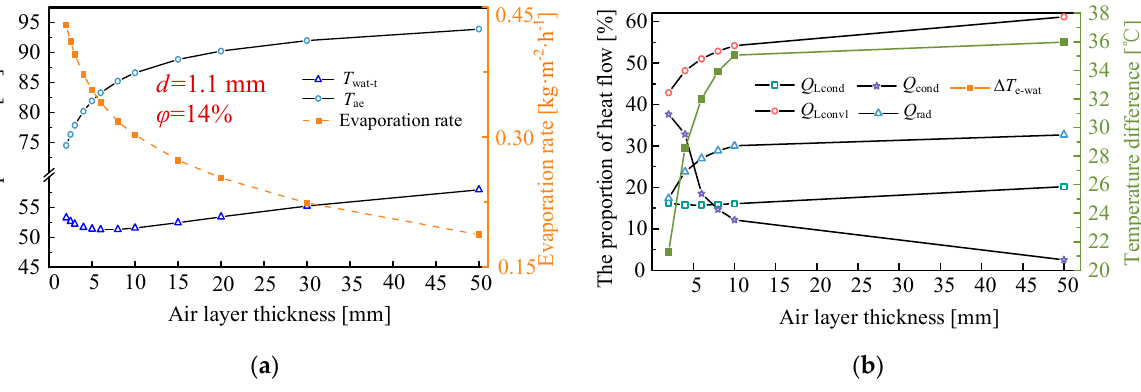
Figure 10. ( a ) T ae , T wat-t and evaporation rate under different air layer thickness, with the same hole diameter ( d = 1.1 mm) and hole area ratio ( φ = 14%). ( b ) The temperature difference between the water surface and infrared emitter surface and the proportion of heat flow under different air layer thickness.